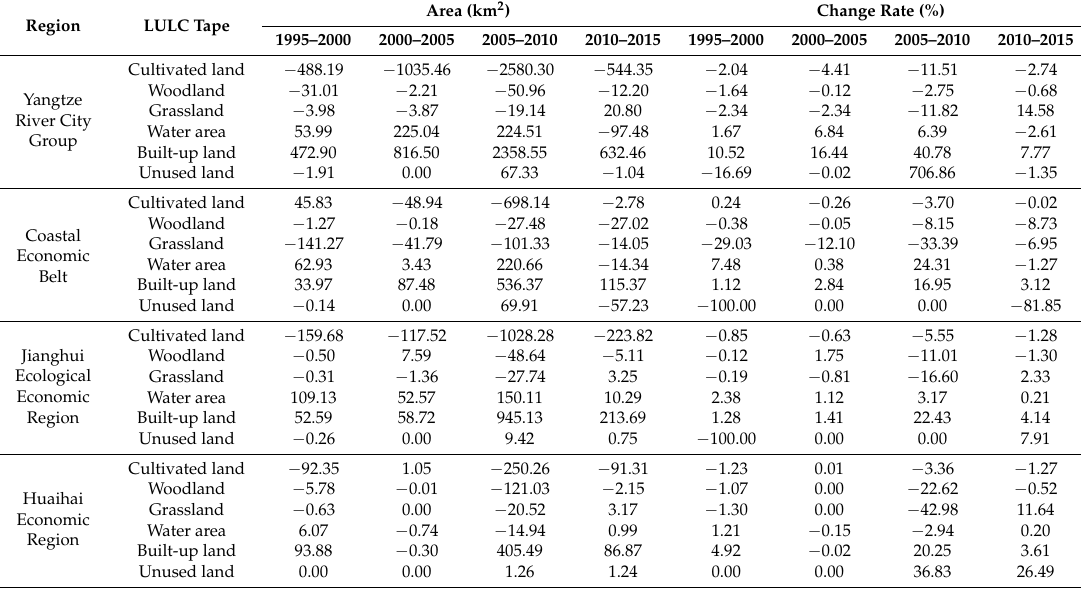
Table 4. The amounts of LULC changes between typical years in the four functional